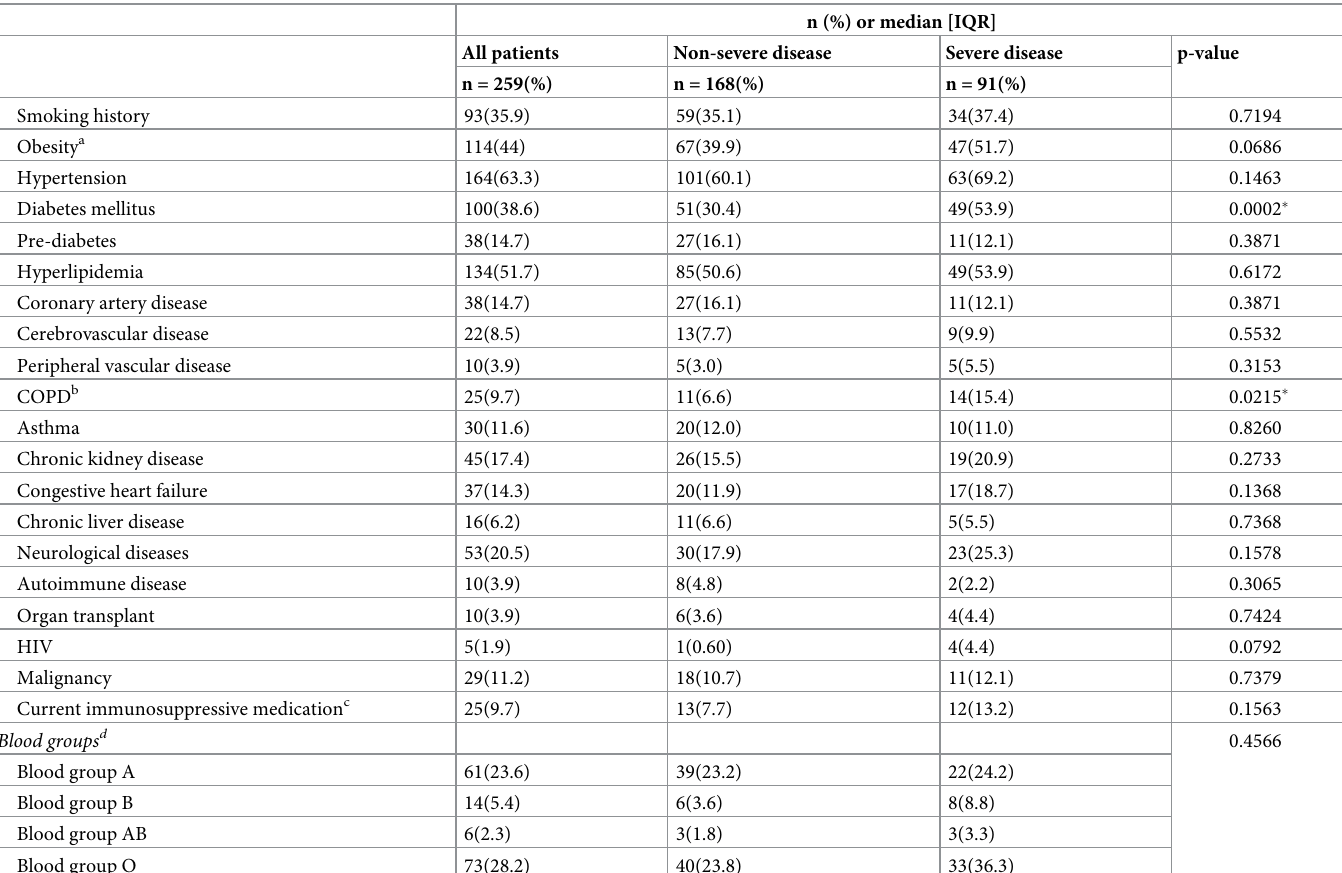
Table 2. Medical